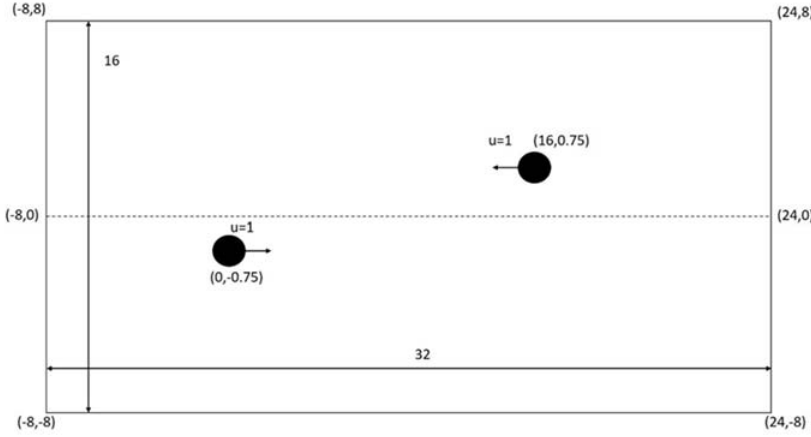
Figure 5. Schematic diagram of two moving cylinders in a viscous fluid domain.